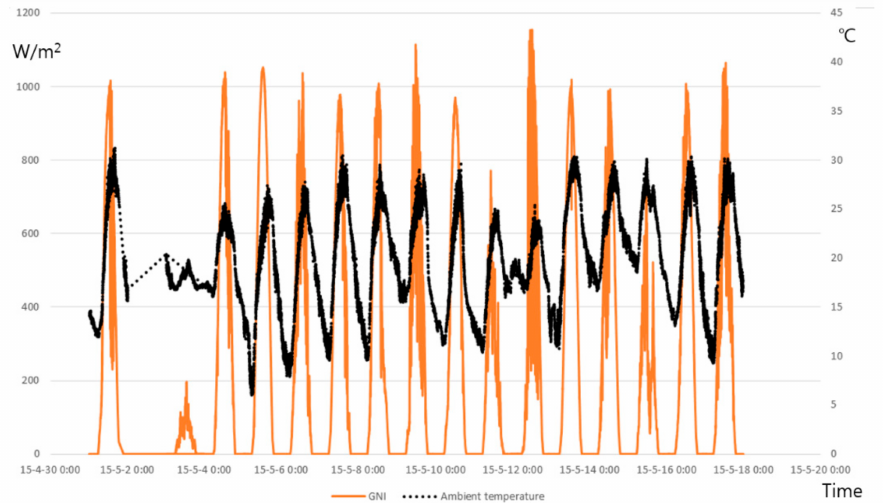
Figure 3. Global Normal Irradiance (GNI), ambient temperature (1–17 May